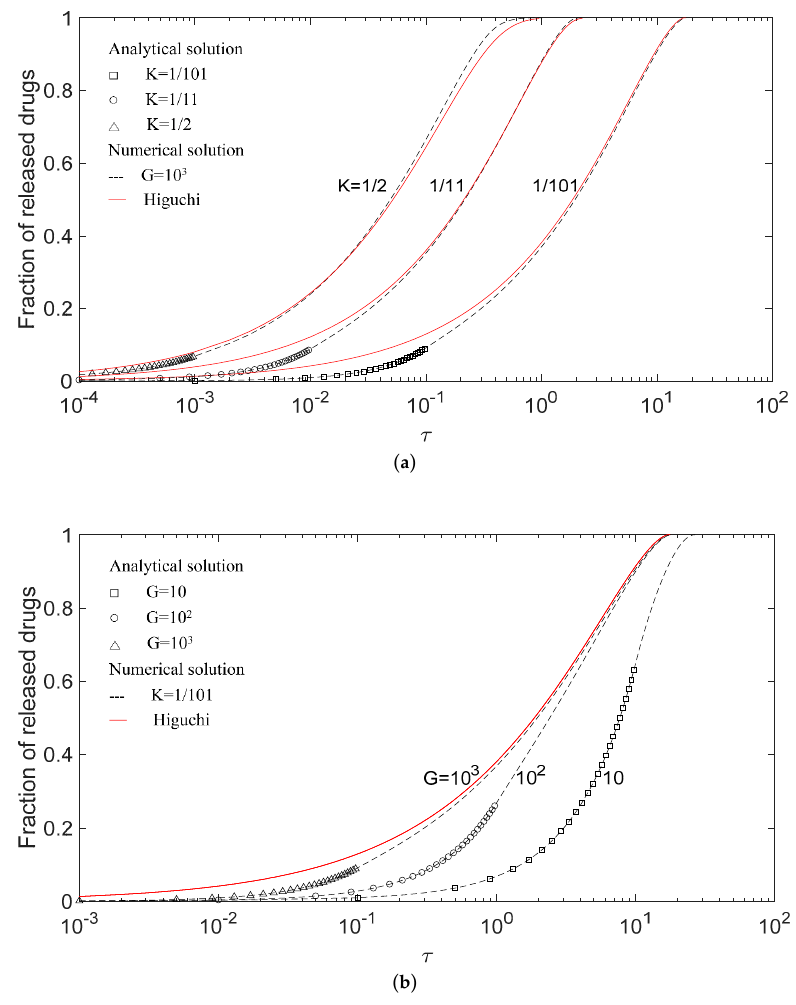
Figure 2. Comparison between Higuchi’s model and this present model for ( a ) G = 10 3 with different K , from right to left, K = 1/101, 1/11, and 1/2, and ( b ) K = 1/101 with different G values from right to left, G = 10, 10 2 , and 10 3 . The marker is the analytical solution.